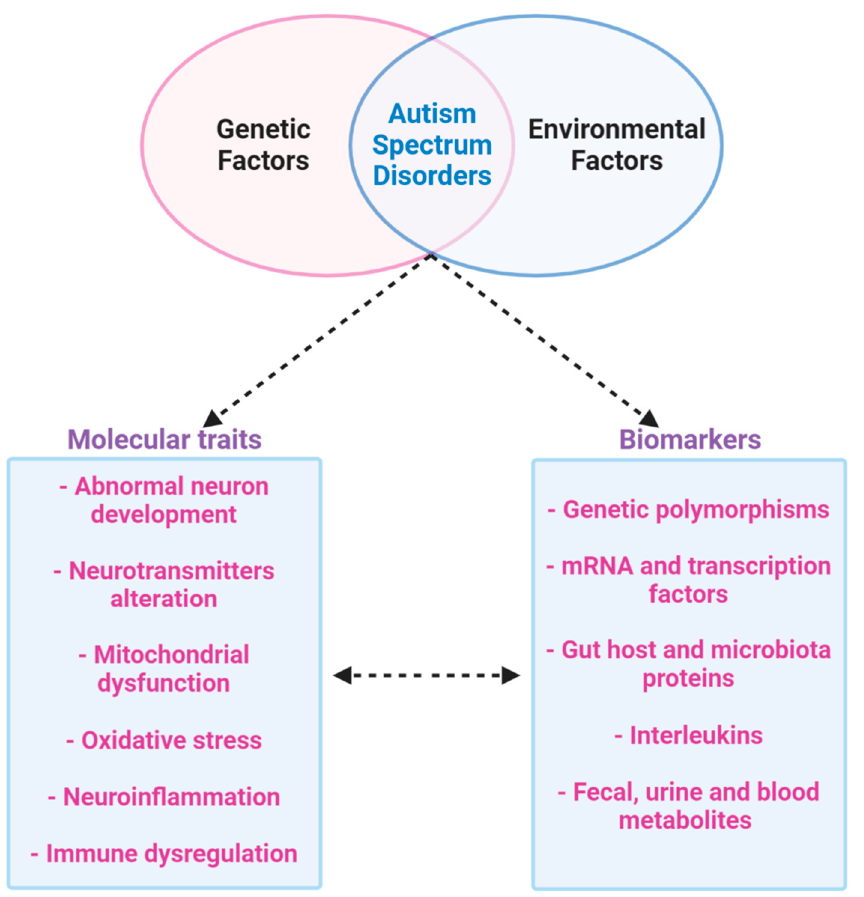
Figure 7. Multi-omics approach to ASD. ASD is a multifactor disease that includes genetic and environmental factors. The phenotype of ASD determines abnormal neurodevelopment with alteration in neurotransmitters. Furthermore, ASD is characterized by mitochondrial dysfunction, oxidative stress, inflammation and abnormal immune regulation. All of these dysfunctions produce possible biomarkers that could be identified by a new multi-omics approach to studying ASD.